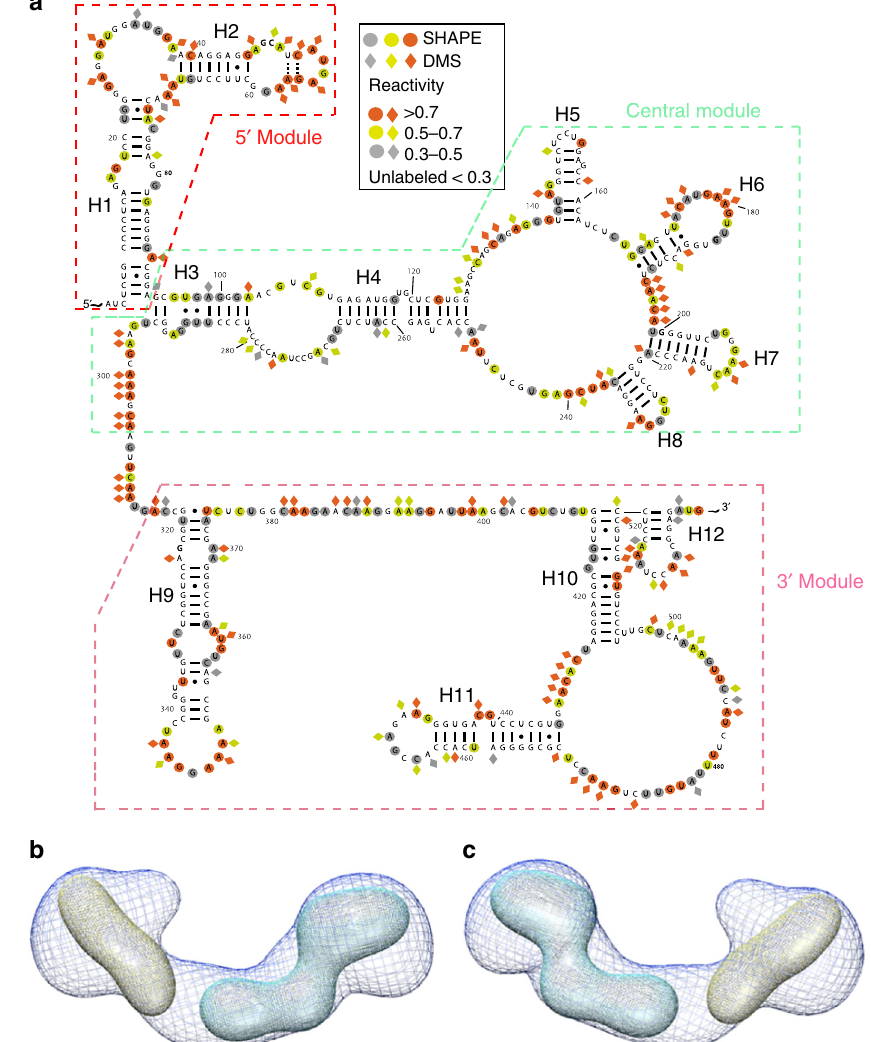
Fig. 3 Structural studies of Bvht modular sub-domains at 6 mM Mg 2 + . a Secondary structures of full-length Bvht based on chemical probing experiments, depicting its modular sub-domains. b Averaged 3-D SAXS solution conformation of full-length Bvht and its modular sub-domains. Blue mesh, averaged solution structure of full-length Bvht ; yellow, 5 ′ module of Bvht ; cyan, 3 ′ module of Bvht . While multiple orientations of the modules fi t into the full-length map, we chose orientations most consistent with the connectivity of the secondary structure. c 180° rotated view of ( b